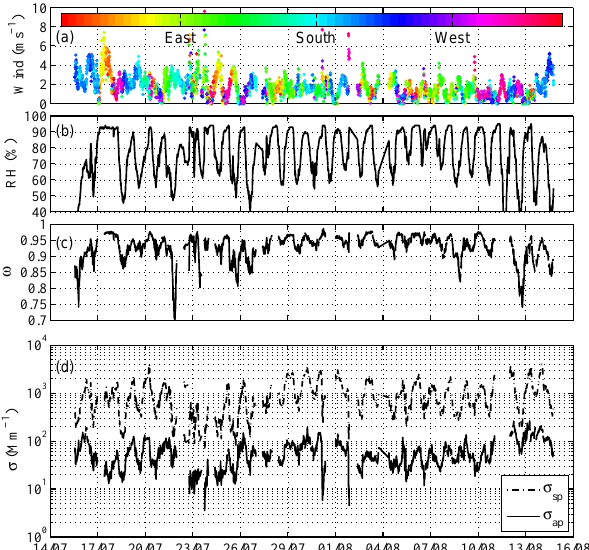
Figure 2. Average diurnal pattern of σ ep (a) , σ sp (b) , σ ap (c) , ω (d) , ambient RHs (e) and the result of autocorrelation analysis of all the variables above (f) with the significant level of 0.1 (the dashed straight lines). The boxes and whiskers represent the 5, 25, 75, 95th